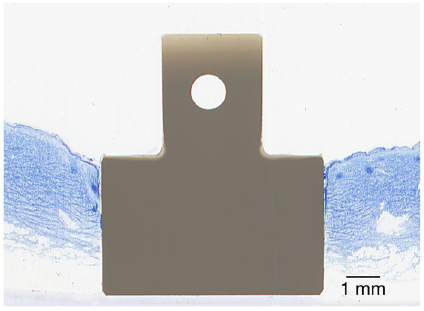
Fig. 5 Histology slide, stained with toluidine blue, showing a PEEK implant (unmodi fi ed) placed in the skin